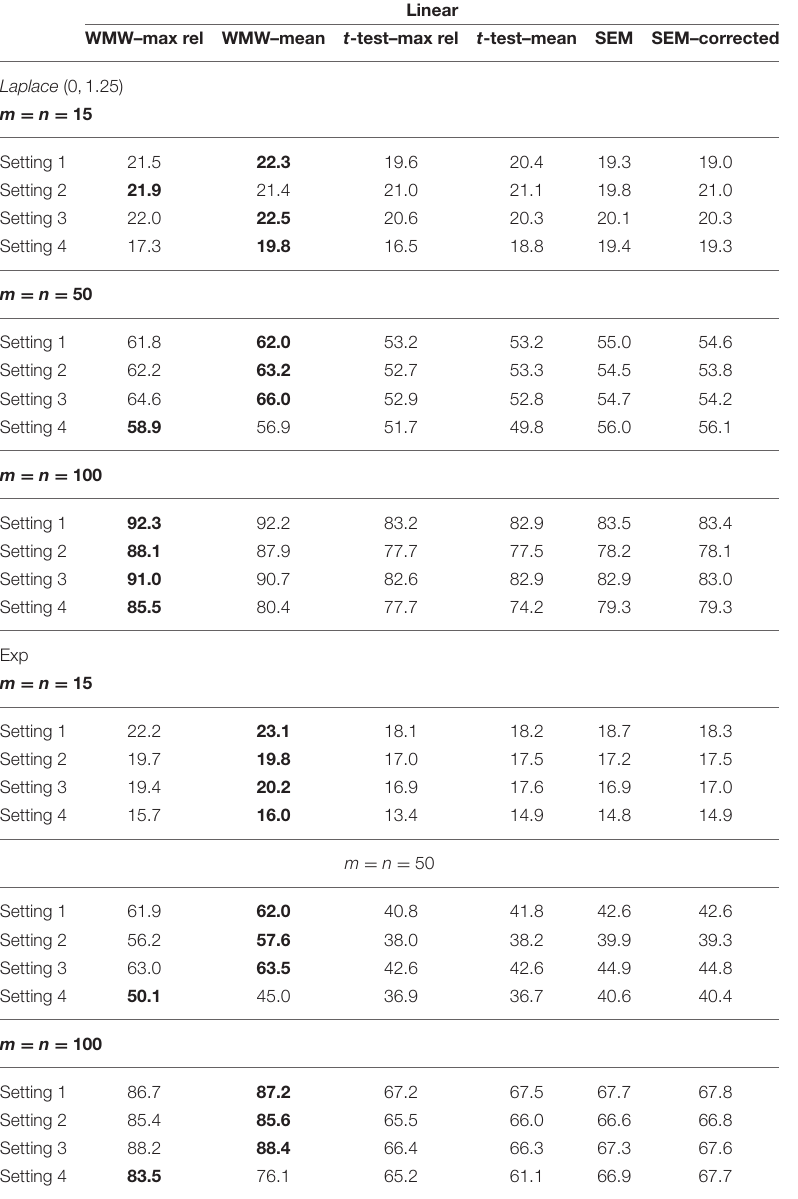
The highest power per setting is indicated in